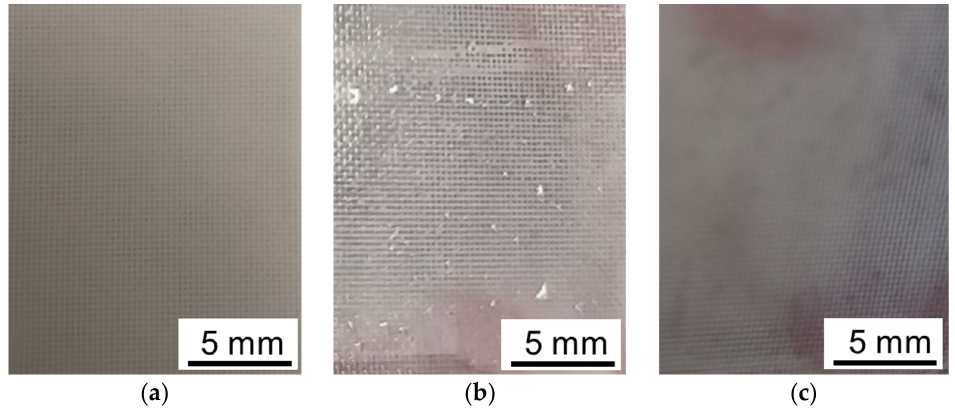
Figure 7. Photo of the surface of the CJMC-5 membrane before ( a ) and after its using in ED processing model solutions 3 ( b ) and 4 ( c ).